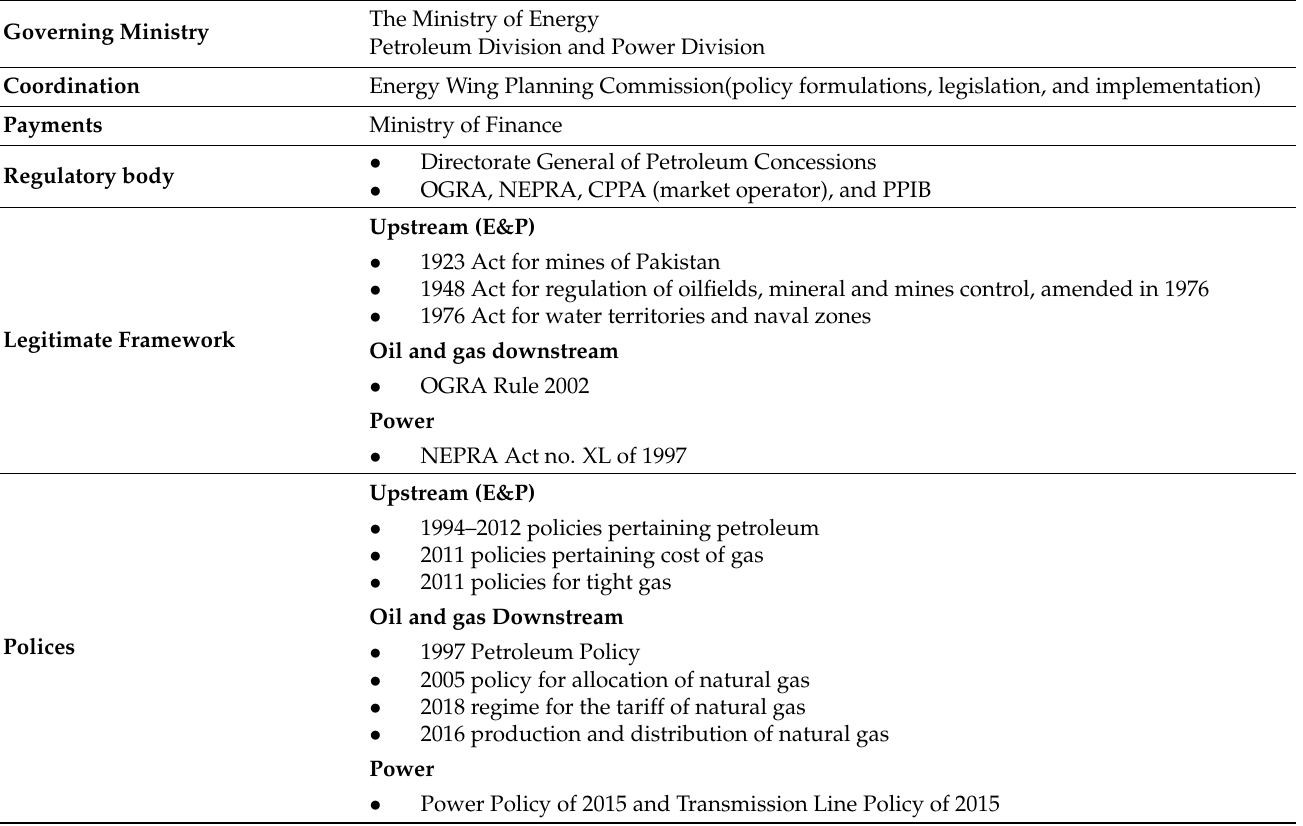
Table 1. Key energy infrastructure organizations and their roles and responsibilities